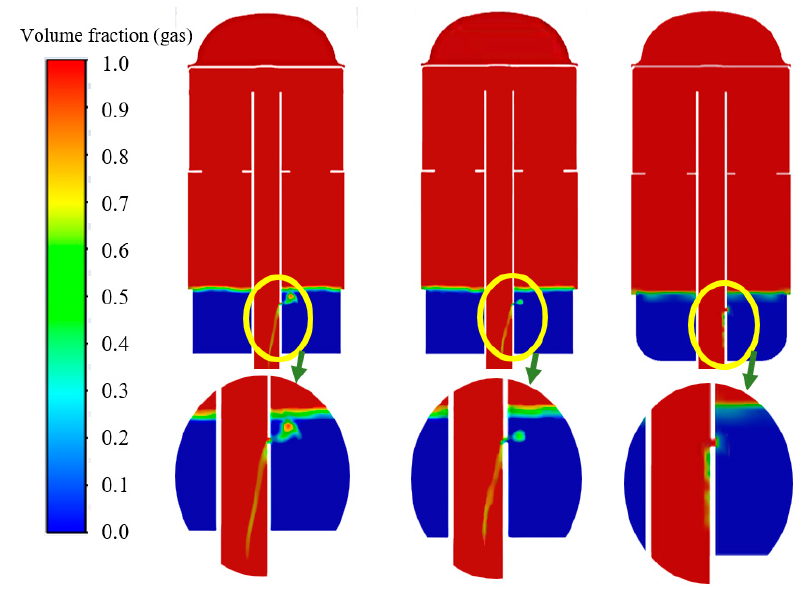
Figure 9. Shape of the liquid flowing out of the liquid-return holes. s = 100% s = 50% s = 20%. The two-phase flow pattern in the liquid-return hole depends on the velocity vector diagram. Figure 10 shows the velocity vector diagrams. It can be seen that when the solu- bility is 100% and 50%, liquid backflow occurs in the accumulator through the liquid- return hole, so a vortex will be formed in the suction pipe. When the solubility is 20%, the fluid velocity near the suction-pipe wall is almost 0, which prevents the droplets along the inner wall of the suction tube from being blown into the inside of the suction pipe. Figure 10. Velocity vector in the liquid-return hole and the suction pipe. s = 100% s = 50% s = 20%. 4.2. Effects of Refrigerant/Oil Type on Liquid-Return Characteristics The thermal-physical properties of different refrigerants vary greatly, which would result in different liquid-return characteristics. Under the same conditions in Section 3, by using different refrigerants (R290, R22, R410A), the liquid-return characteristics in the ac- cumulator at the refrigerant solubility of 20% is simulated. The common oils, NM56 for